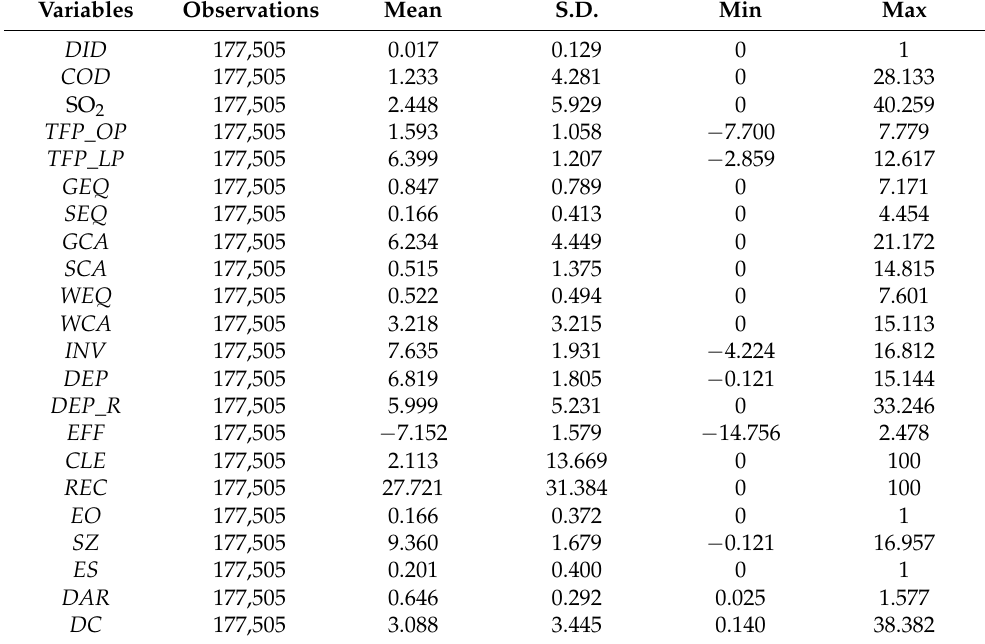
Table 1. Statistical description of relevant